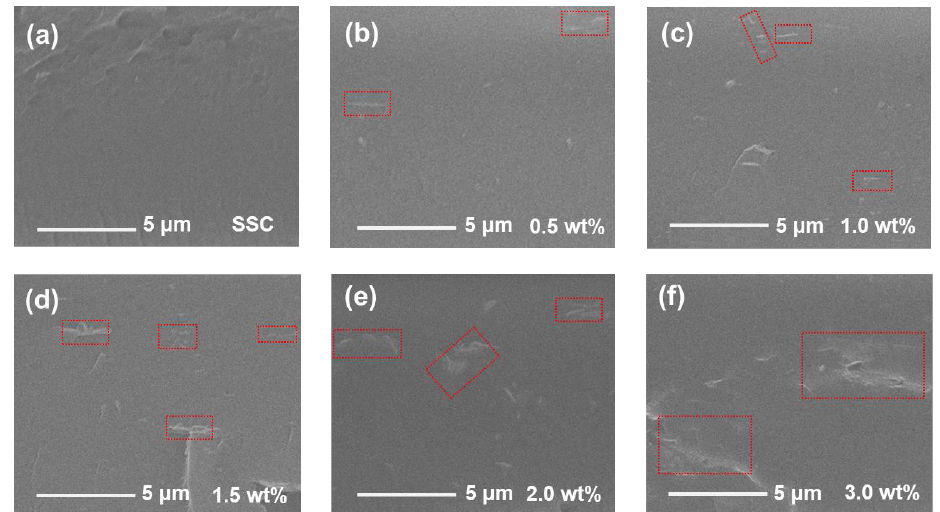
Figure 5. Cross-sectional SEM images of the membranes. ( a ) SSC; ( b ) SSC/Ti 3 C 2 T x -0.5; ( c ) SSC/Ti 3 C 2 T x -1.0; ( d ) SSC/Ti 3 C 2 T x -1.5; ( e ) SSC/Ti 3 C 2 T x -2.0; and ( f ) SSC/Ti 3 C 2 T x -3.0.